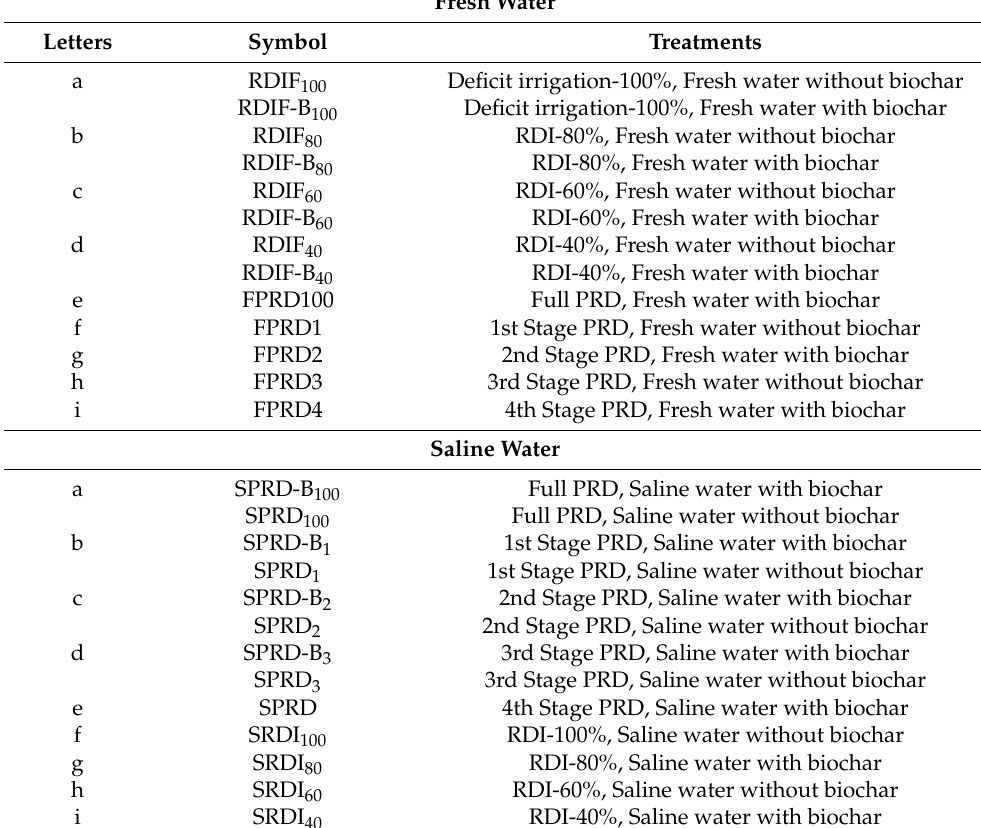
Table 3. Combination of treatments using saline and fresh